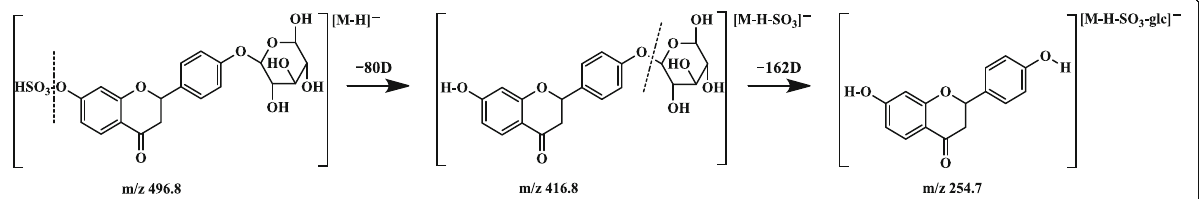
Fig. 5 Analysis of the cracking pathway of liquiritin 7- O -sulfate (peak 8 in Fig. 2c) using ESI-MS scanning in negative ion